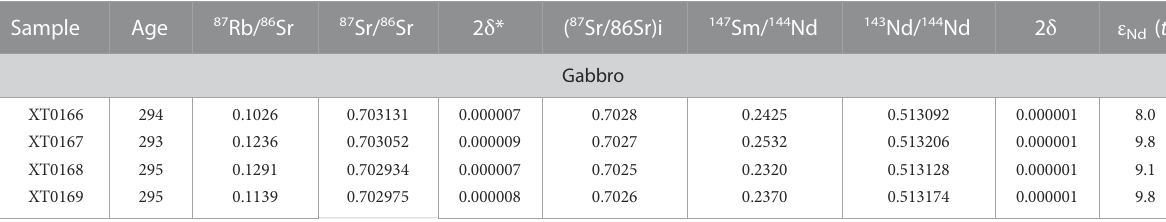
TABLE 3 Sr – Nd isotopic compositions of the gabbro in Diyanmiao ophiolite. Sample